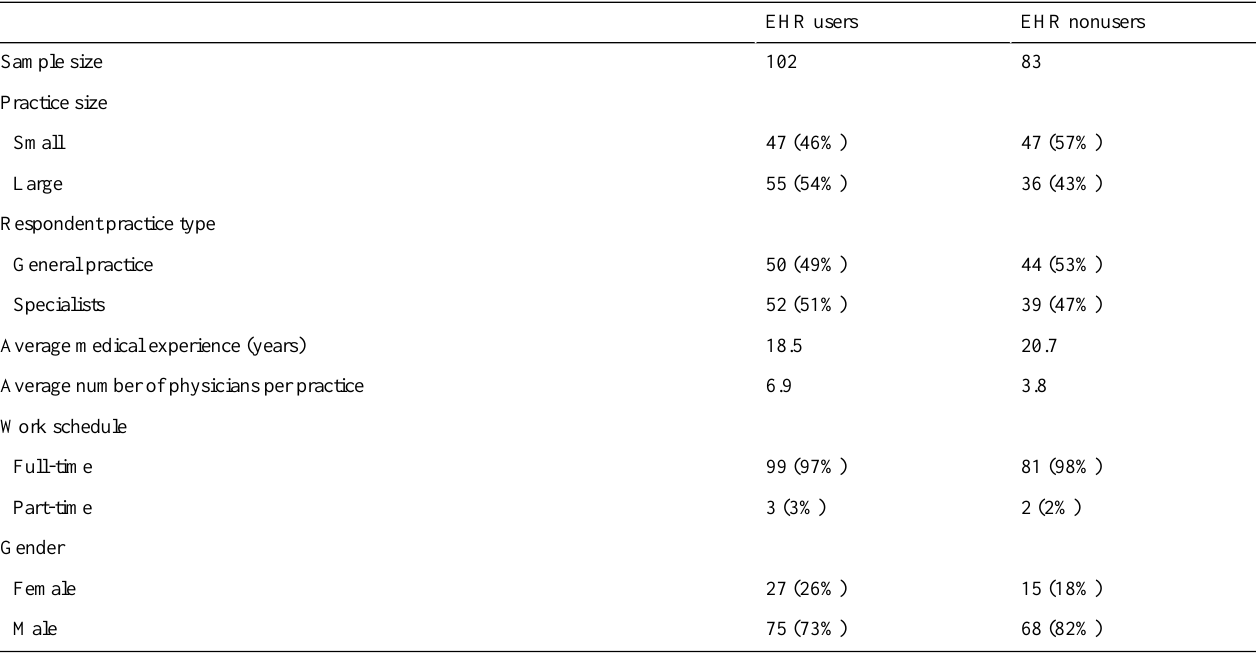
Table 1. Participant